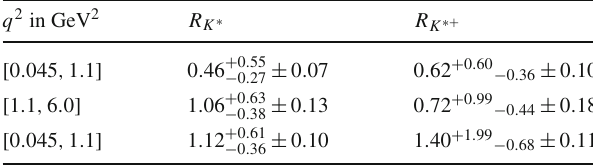
Table 1 R K ∗ and R K ∗+ results from Belle